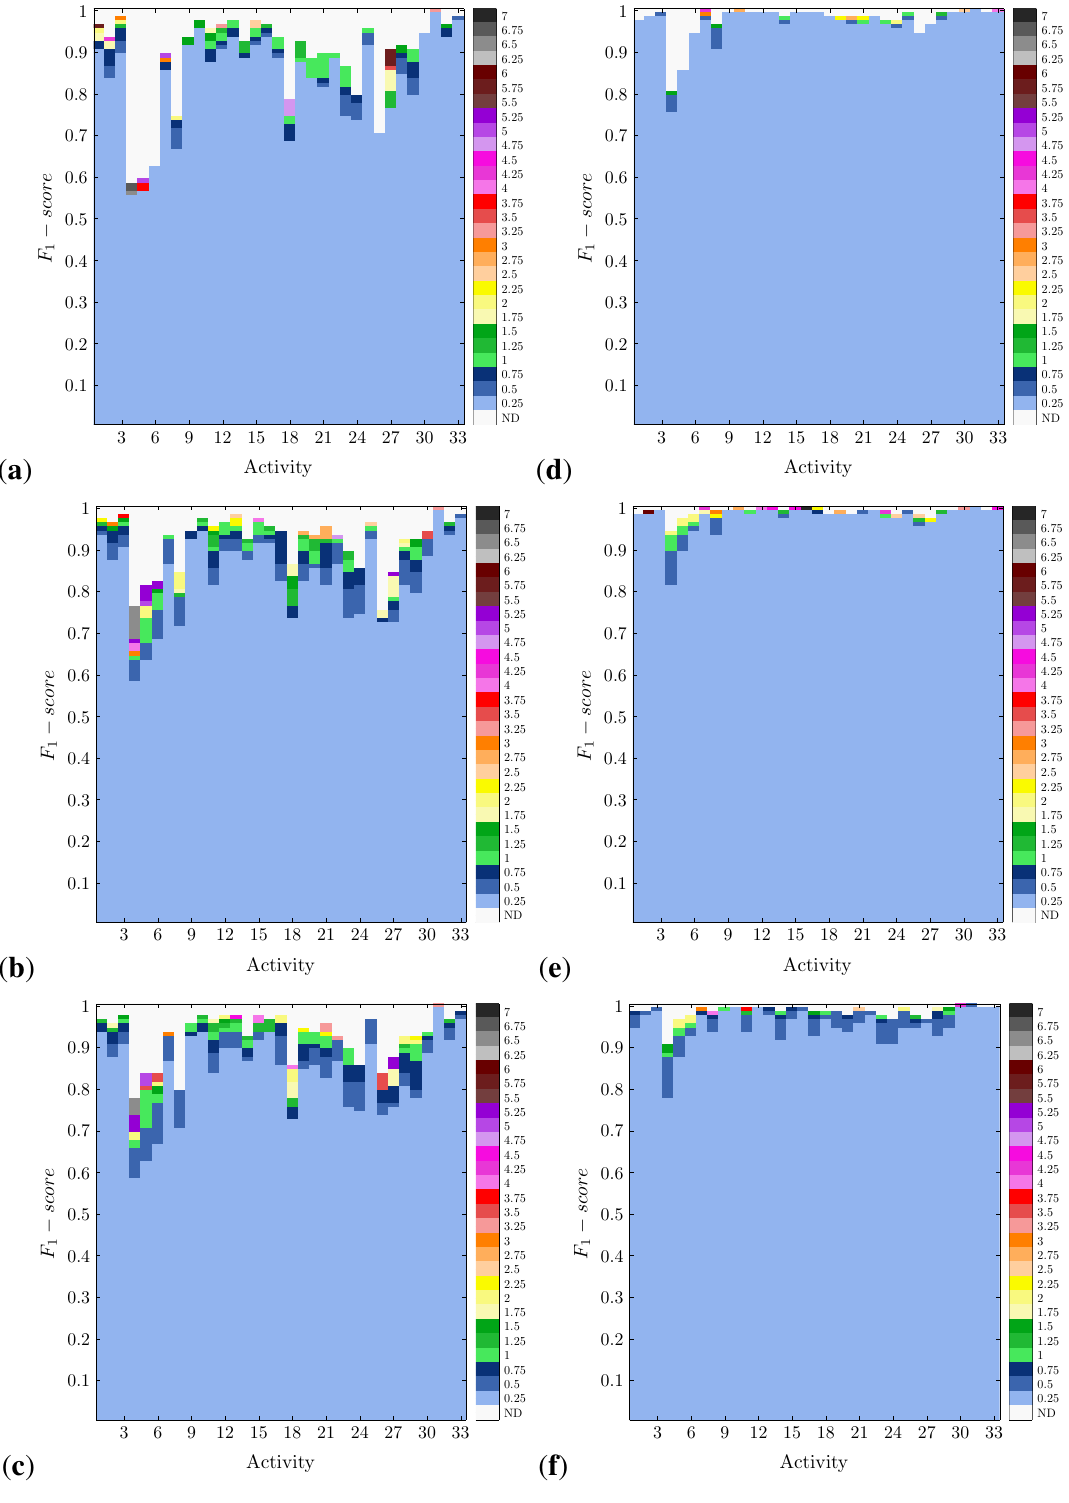
Figure 5. Activity-specific recognition performance for diverse window sizes and methodologies ( < classification paradigm > - < feature set >